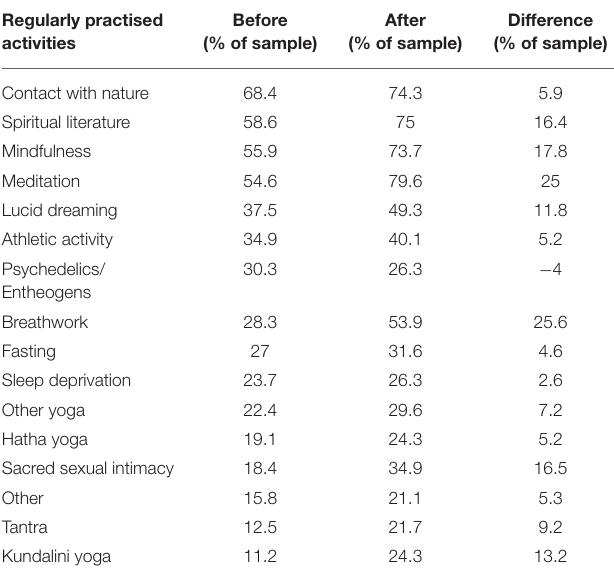
TABLE 1 | Reported regularly practised activities before and after the participants’ most powerful